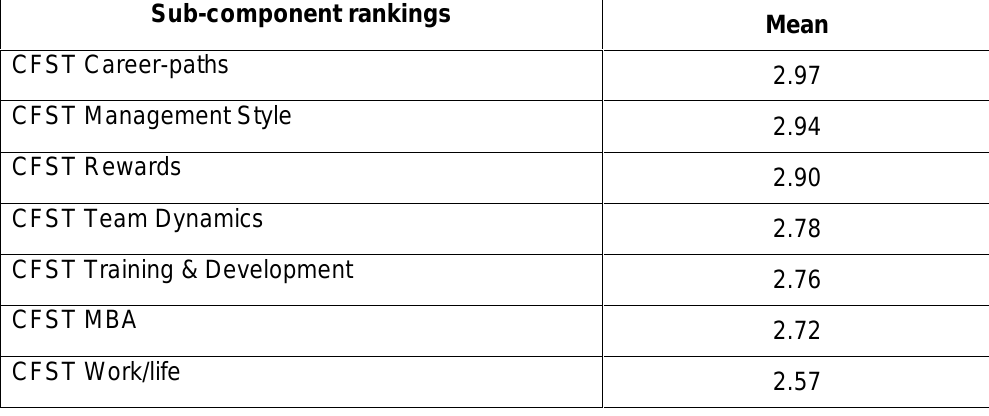
Table 10 : Ranking of the 7 sub-components of the